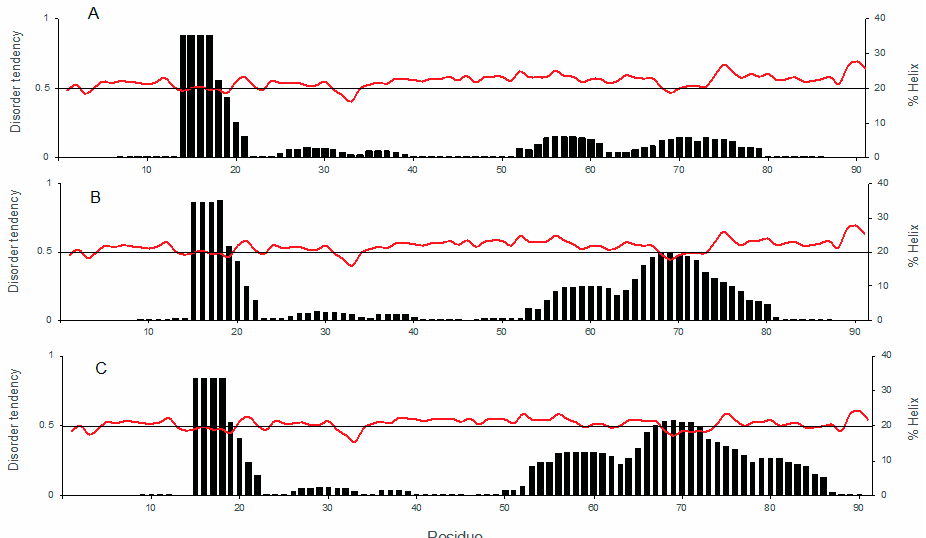
Figure 2. AGADIR % helix and IUPred disorder predictions for individual residues in COR15A wildtype (WT) and mutants. The AGADIR predictions are represented by the black bars, while the IUPred predictions are represented by the red line. ( A ) COR15A WT, ( B ) single mutant G68A, ( C ) quadruple mutant 4GtoA. The primary vertical axis represents disorder tendency as predicted by IUPred, while the secondary vertical axis shows the % helix as predicted by AGADIR. The horizontal axis represents the residue number/position.